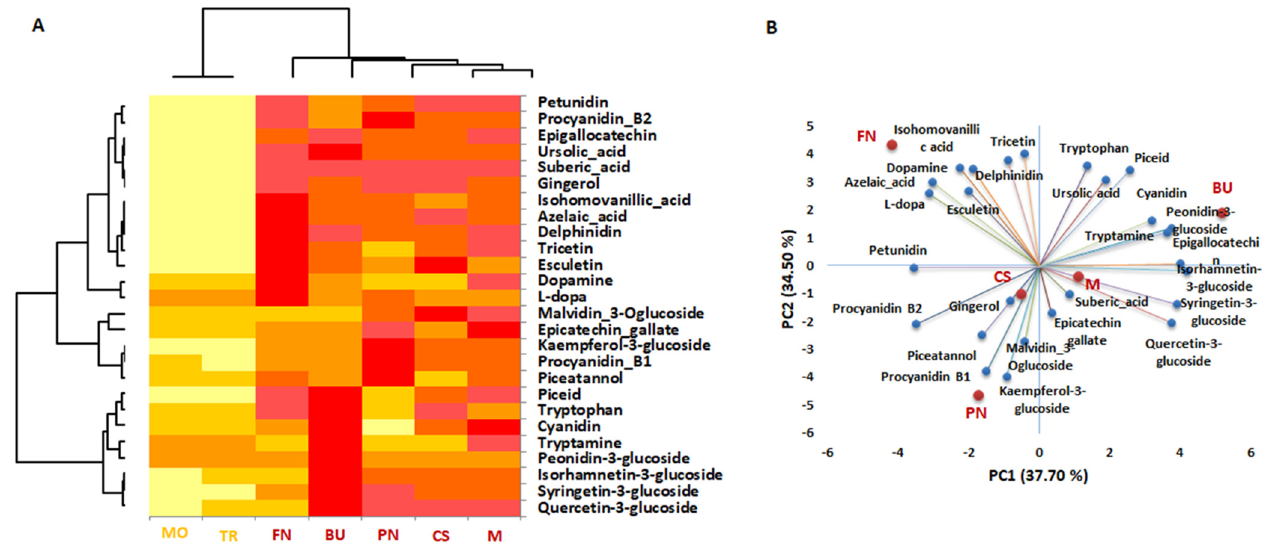
Figure 6. Differentiation of grape pomace based on the phytochemical profiles (qualitative data): Heat map ( A ) and PCA ( B ) (MO-Muscat Ottonel, TR-Tamaioasa Romaneasca, PN-Pinot Noir, CS-Cabernet Sauvignon, FN-Feteasca Neagra, M-Merlot, BM-Burgun Mare).